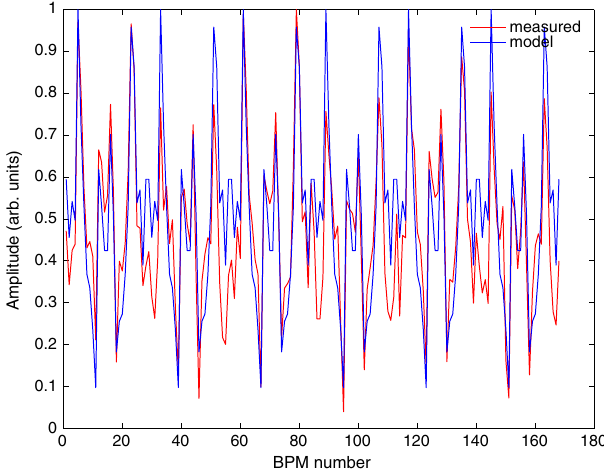
FIG. 4. (Color) Comparison of the amplitude of the ð(cid:1) 1 ; 1 Þ line in the vertical plane. The spectral line from the model is blue while the measured one is in red.